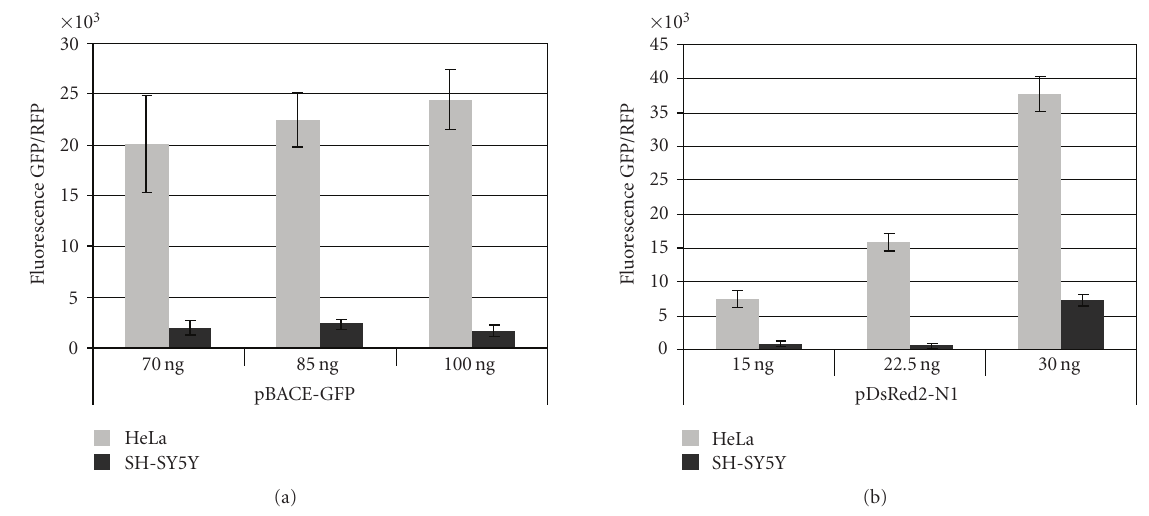
Figure 2: Comparison of transfection e ffi ciency of pGFP-BACE or pDsRed2-N1 plasmids in HeLa and SH-SY5Y cells.